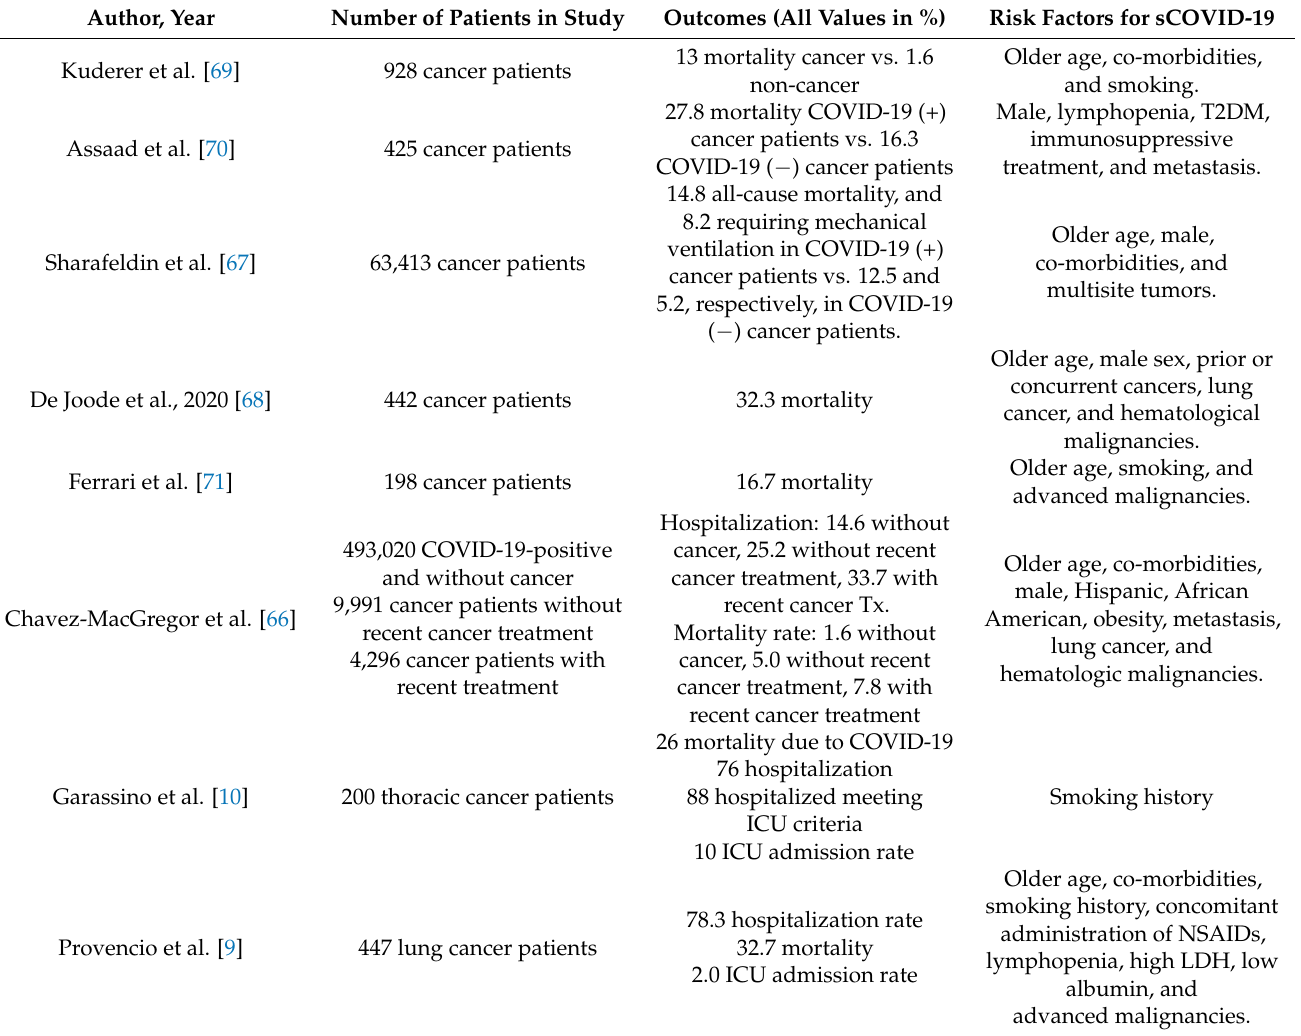
Table 1. Summary of studies evaluating COVID-19 outcomes in cancer